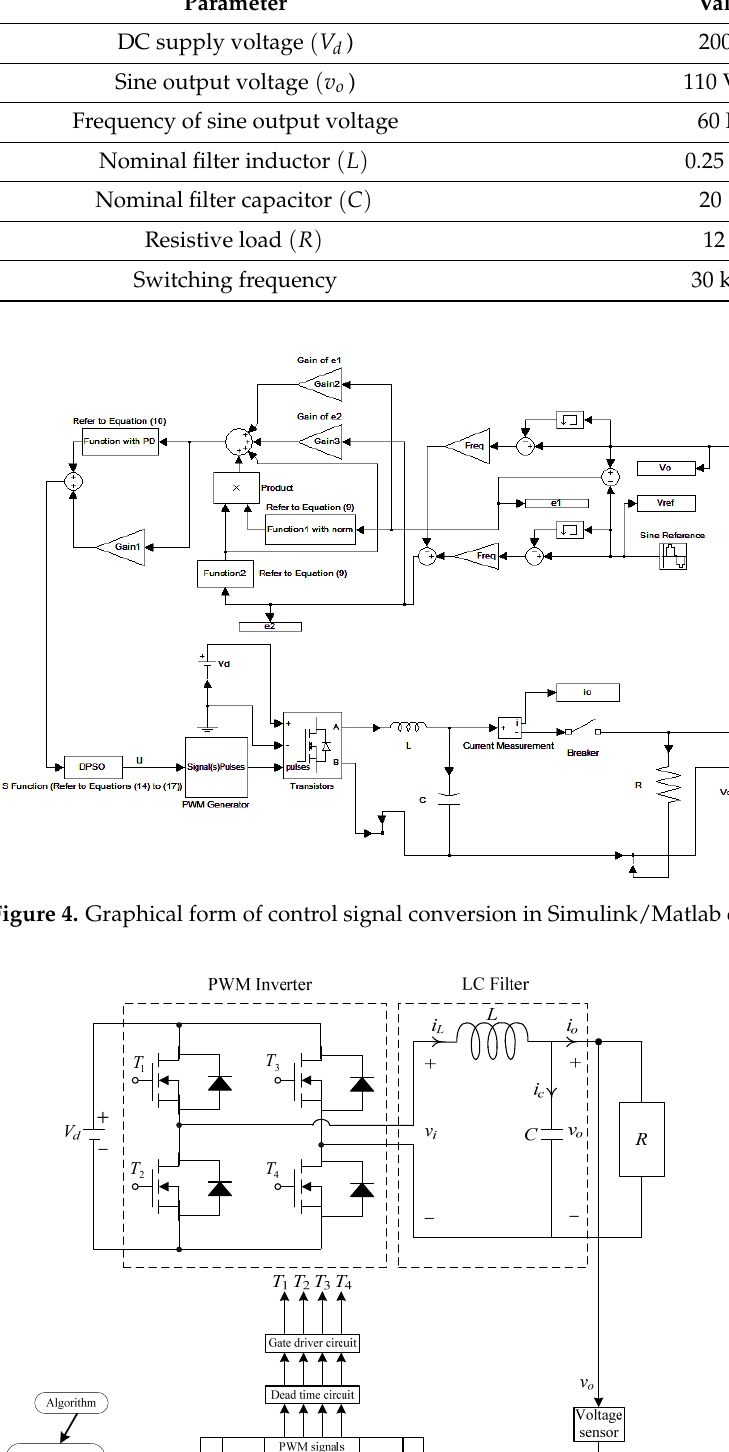
Figure 6. Photograph of the hardware implementation.